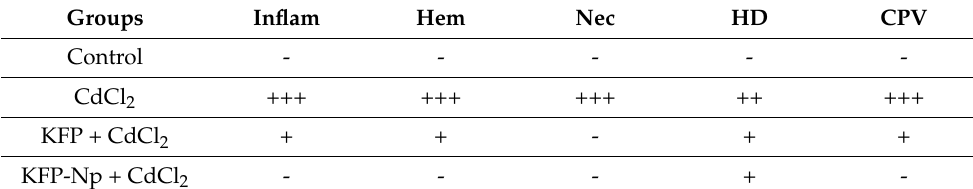
Figure 6. Histological analysis as disclosed by haematoxylin/eosin staining of liver sections from (representative microphotographs). Scale bar: 100 µ m. ( A ) Control group; ( B ) CdCl 2 -treated group; ( C ) KFP + CdCl 2 ; ( D ) KFP-Np + CdCl 2 (H&E X400). CV (central vein). Black arrow showed aninfilteration of cells. Table 5. Histopathological alterations of hepatic tissue.